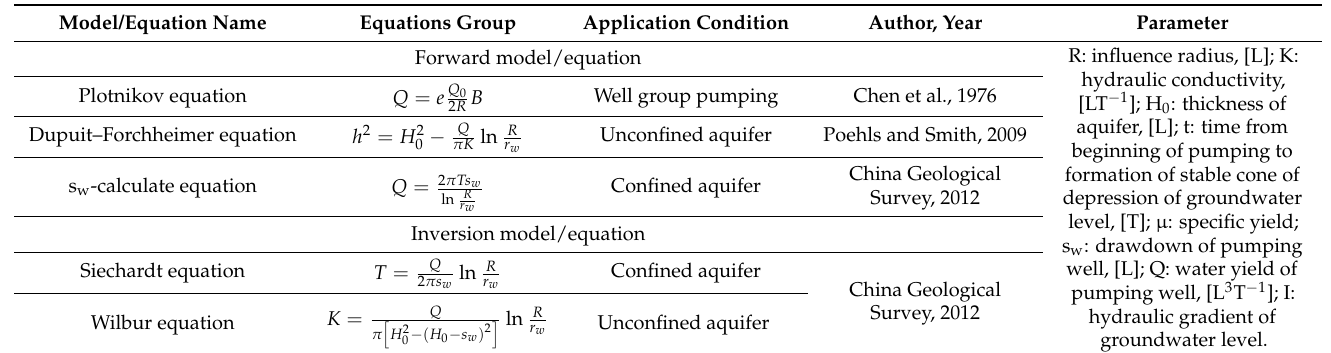
Table 2. Analytic solution models and equations using the influence radius.